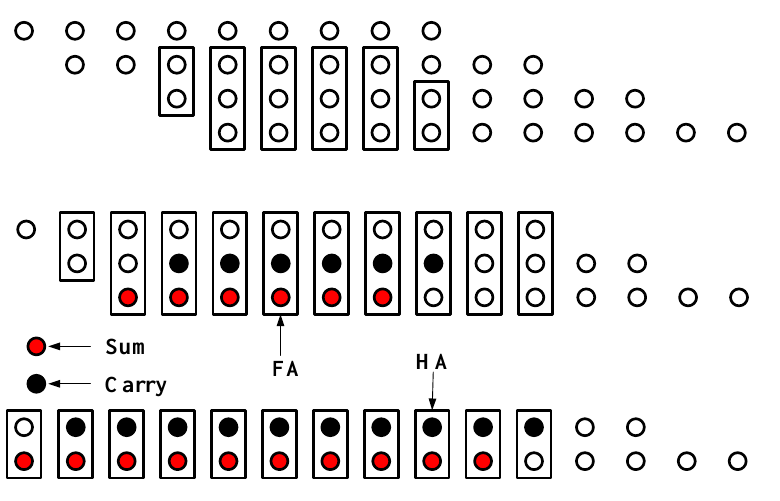
Figure 6. Conventional Wallace tree with three stages.